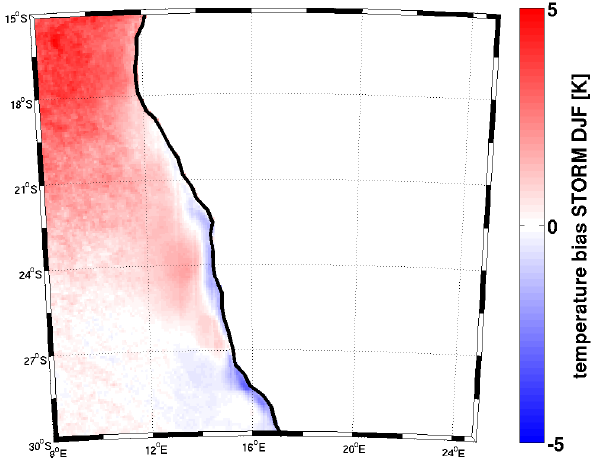
Figure 3. Long-term difference between the simulated SST in the STORM simulation (1950–2010) and the AVHRR-derived (1985– 2009) SST in austral summer (DJF). Units are in